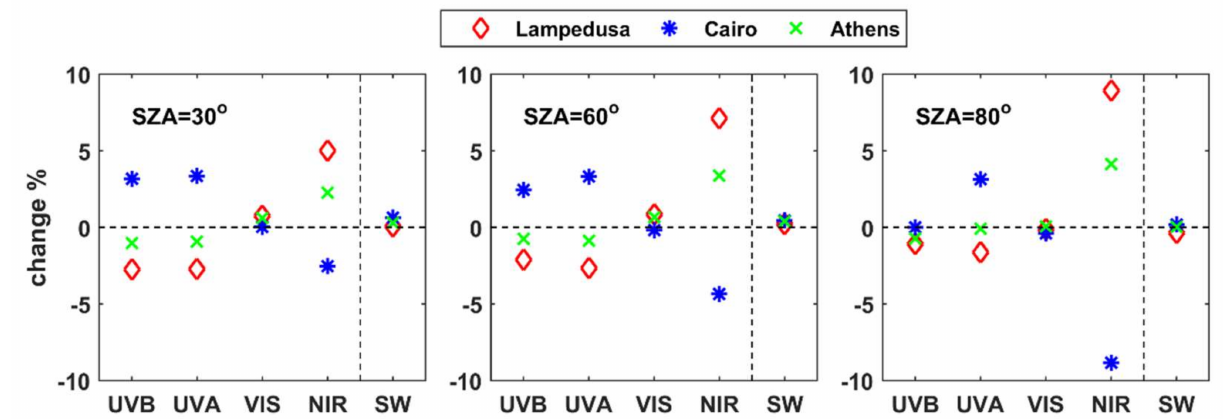
Figure 17. Changes (in %) in the simulated UDI at TOA due to the use of the LIVAS profiles instead of the default